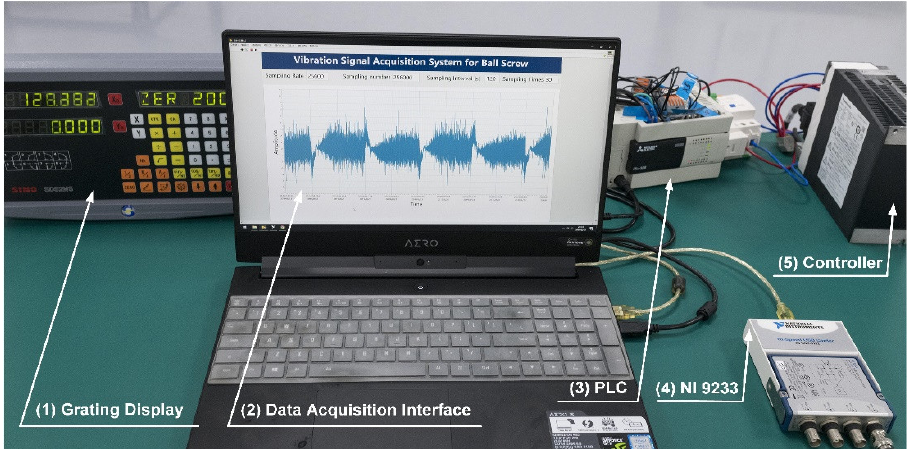
Figure 14. Data acquisition of accelerated degradation process.